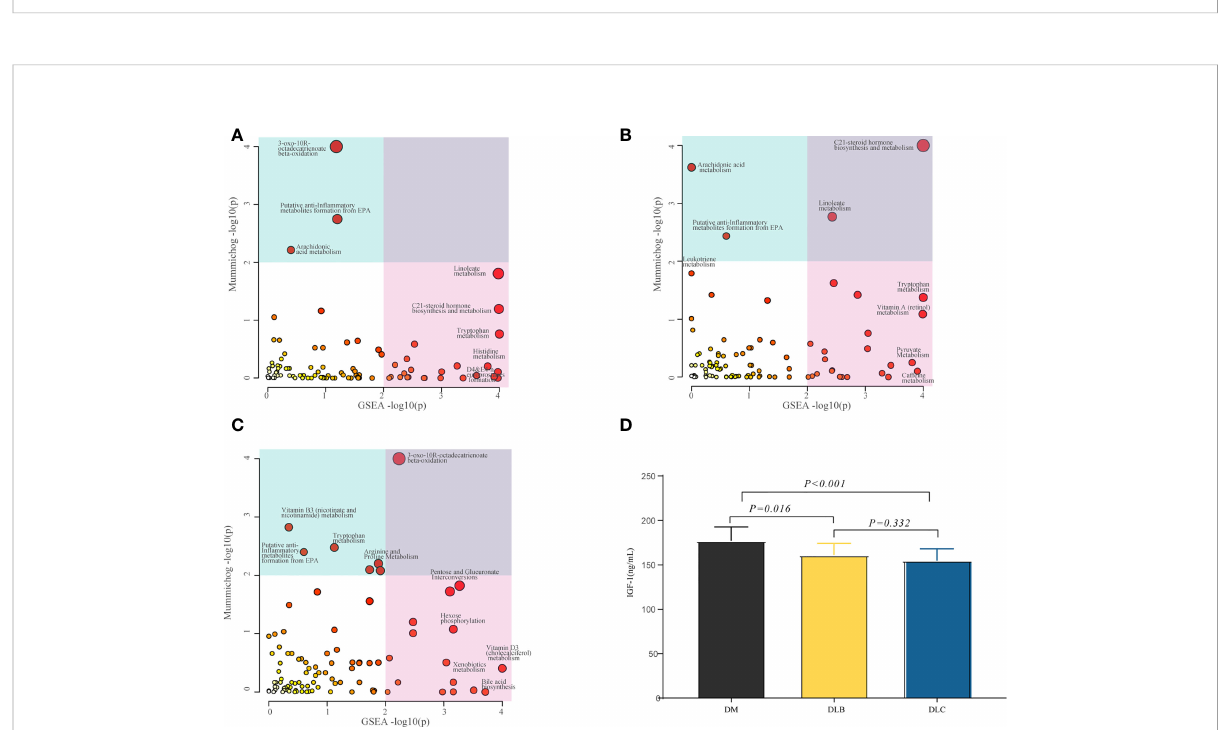
FIGURE 4 Differential metabolic pathway, The bubble plot showing the enriched pathways of DEMs between DLC and DM (A) , the enriched pathways of the DEMs between DLB and DM (B) , the enriched pathways of the DEMs between DLC and DLB (C) ; Serum IGF-1 level among the three groups (D)